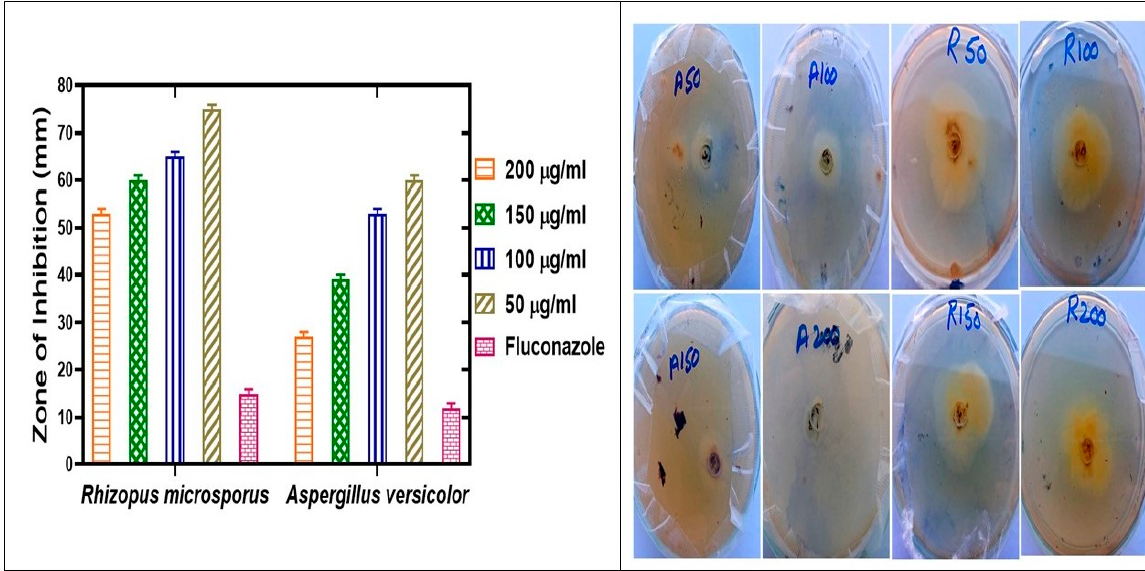
Figure 8. Antifungal potential of Oscillatoria limnetica -mediated IONPs. Table 2. Zone of inhibition (ZOI) and minimum inhibitory concentration (MIC) ZOI and MIC calculation of fungal